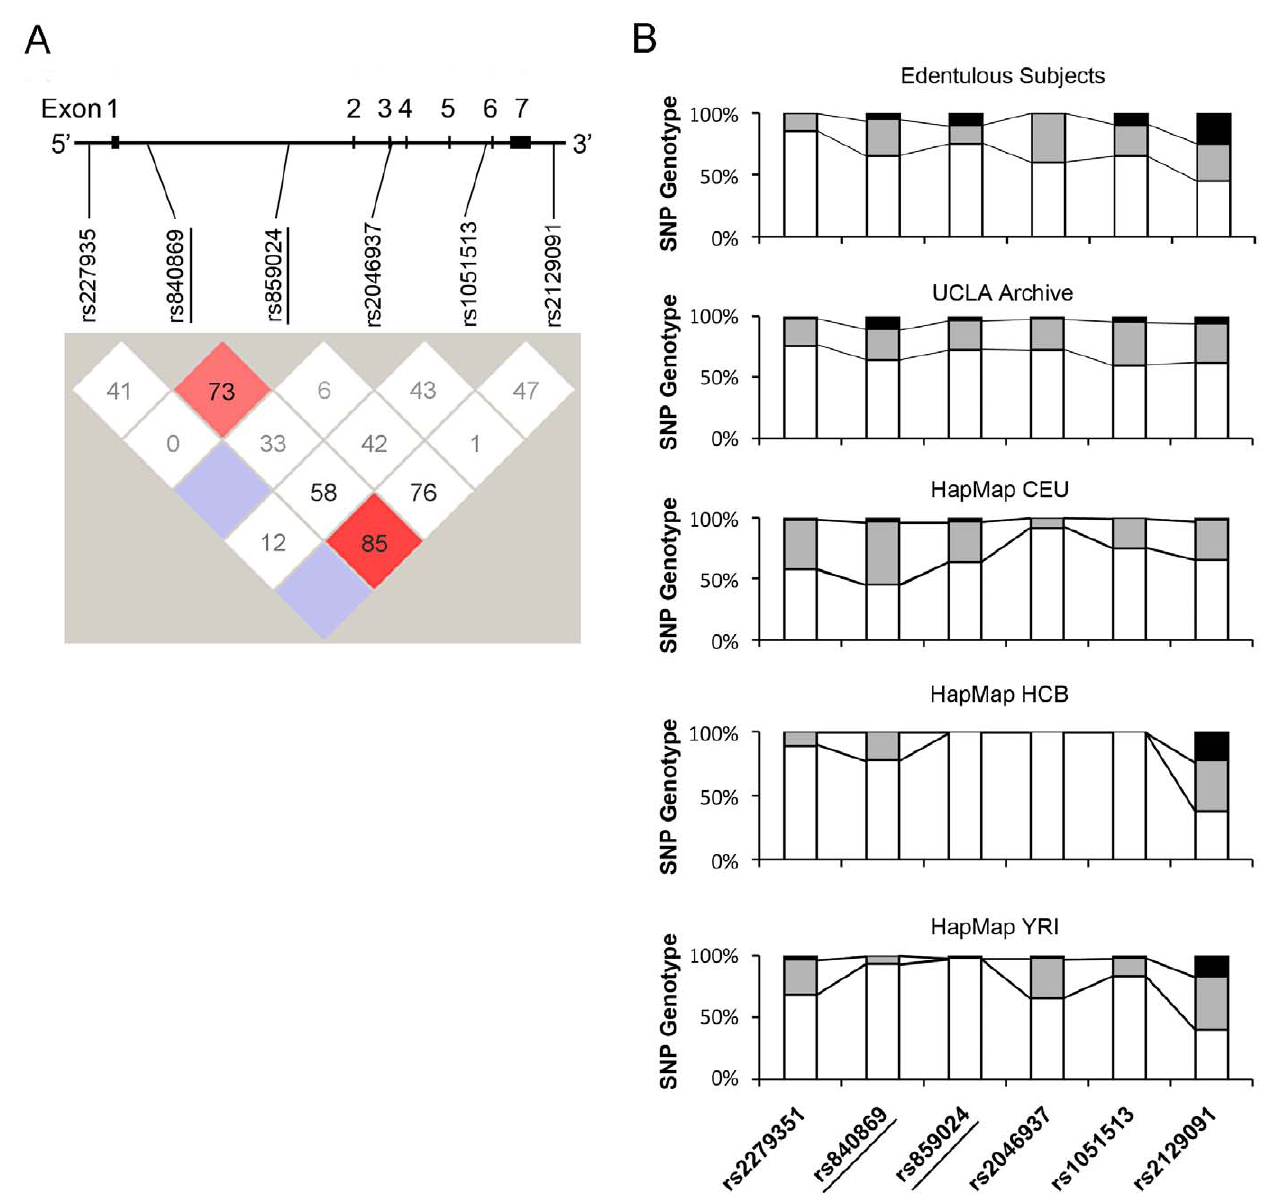
Figure 3. A. SNP-based haplotype analysis of FGFR1OP2/wit3.0 using the UCLA archival DNA samples. An association between rs840869 and rs859024 (underline) was indicated. B . Genotypes of FGFR1OP2/wit3.0 SNPs of edentulous subjects and UCLA archival DNA samples, as well as Western European descendents (CEU), Han Chinese in Beijing (HCB) and Sub-Saharan Africans (YRI) from the HapMap Phase III database. White bar: major allele homozygous; gray bar: heterozygous; and black bar: minor allele